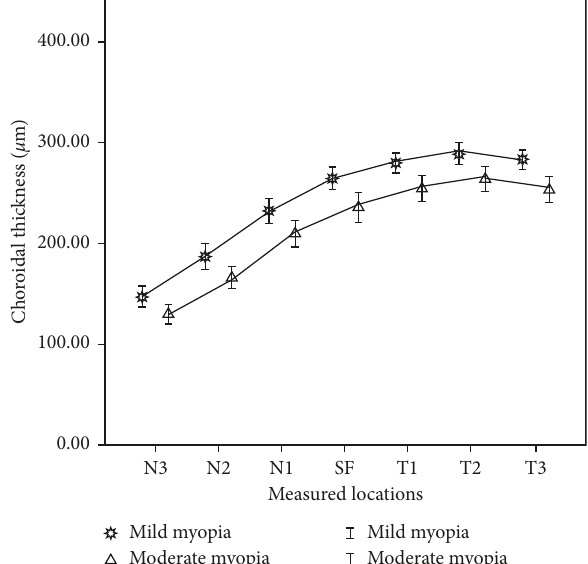
Figure 2: Choroidal thickness of horizontal measured locations in mild and moderate myopia groups: N1, N2, and N3:1, 2, and 3mm nasal to the fovea; SF: subfoveal; T1, T2, and T3: 1, 2, and 3mm temporal to the fovea.